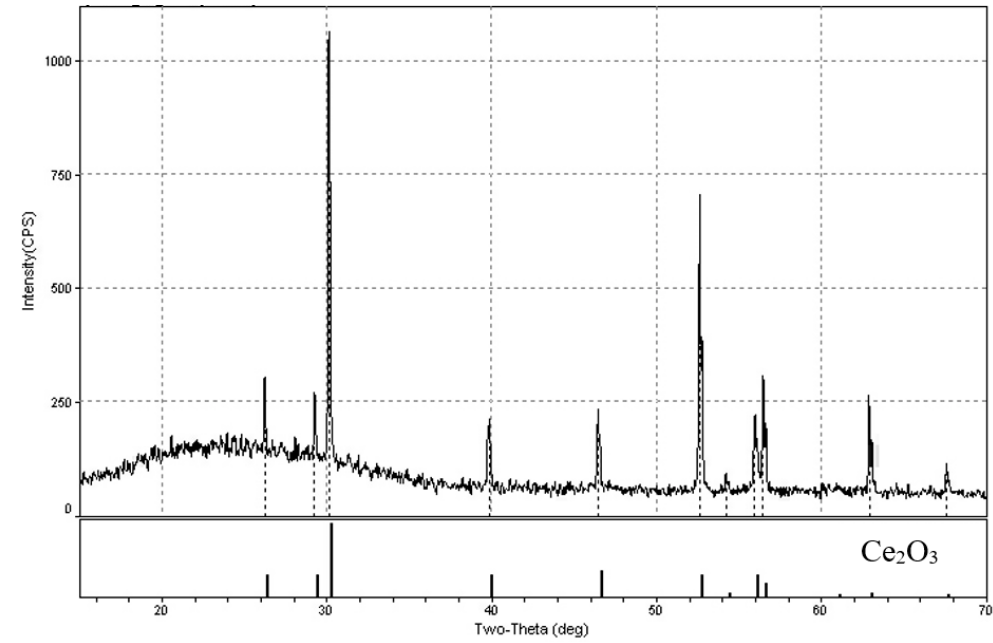
Figure 9. X-ray pattern of Ce 2 O 3 , obtained after the CeO 2 pellet reduction.